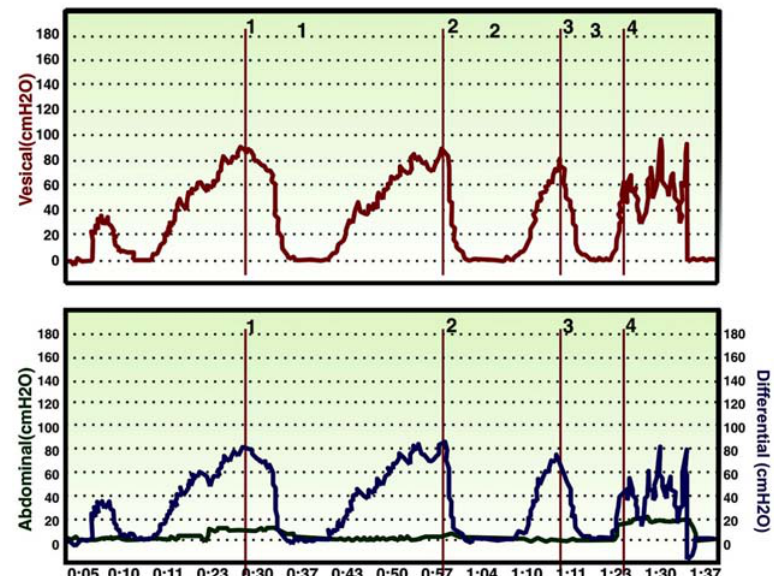
Figure 6 – Urodynamic apparatus pressure records demonstrating that, after making the valve, P1 (red ranging = intestinal pressure) and P2 (green ranging = channel pressure) curves fail to present parallelism, and in cut 1 the valve has 3 stitches, in cut 2, 2 stitches and cut 3 only 1 stitch, maintaining the same effectiveness of the valve. The fourth test represent only the last stitch pressure for confirm the continence with 3